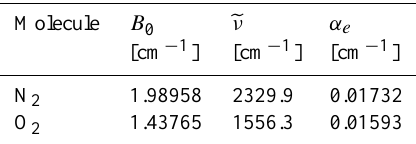
Figure 1. Cross-section of Cabannes line, rotational (RRS – rotational Raman scattering), vibrational (VRS) and rotational– vibrational Raman scattering (VRRS) for a wavelength of 393nm scaled with 0.8 for N 2 and 0.2 for O 2 to reflect their atmospheric concentrations (see also Table 9). The cross-sections were calcu- lated according to Eq. (13) at a scattering angle of (cid:50) = 180 ◦ . As a comparison the Raman response of liquid water according to Hal- trin and Kattawar (1993) is also shown in the plot, scaled arbitrarily. Table 1. The rotational constant B 0 and the vibrational constant e ν for ground state N 2 and O 2 according to Irikura (2007). For excited vibrational states ν > 0 the rotational constant is modified: B ν = B 0 − ν · α e . These constants are used in Eq. (1) to calculate the energy of the molecule E(ν,J)